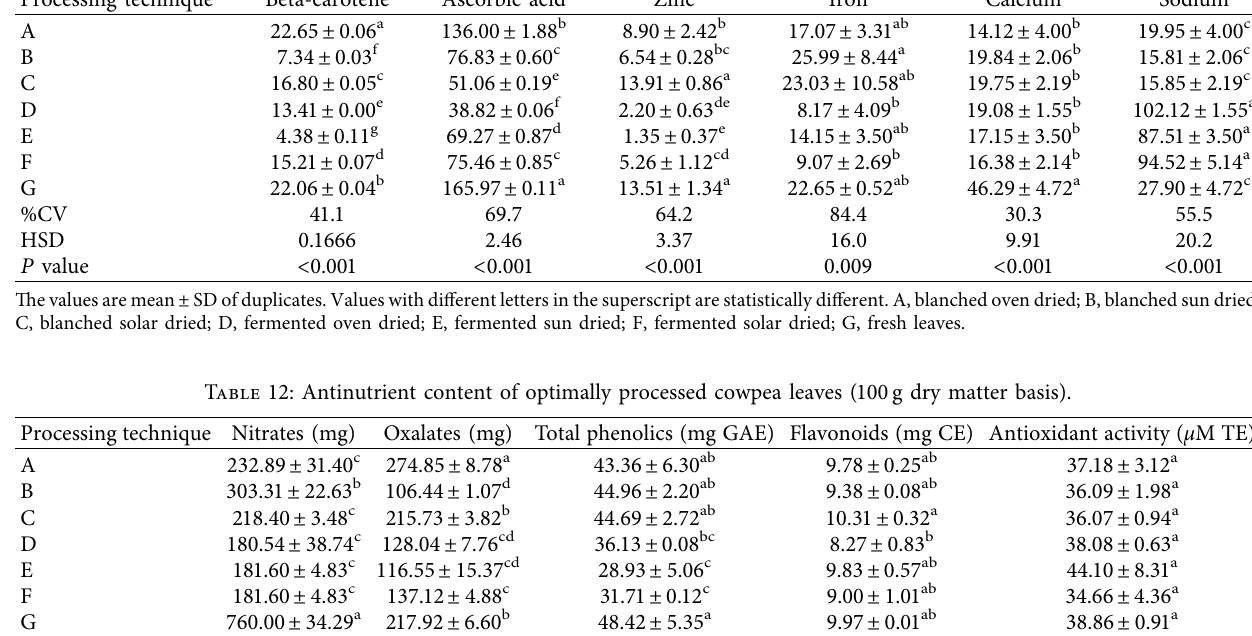
Table 11: Micronutrient composition of optimally processed cowpea leaves (mg/100 g dry matter basis). Processing technique